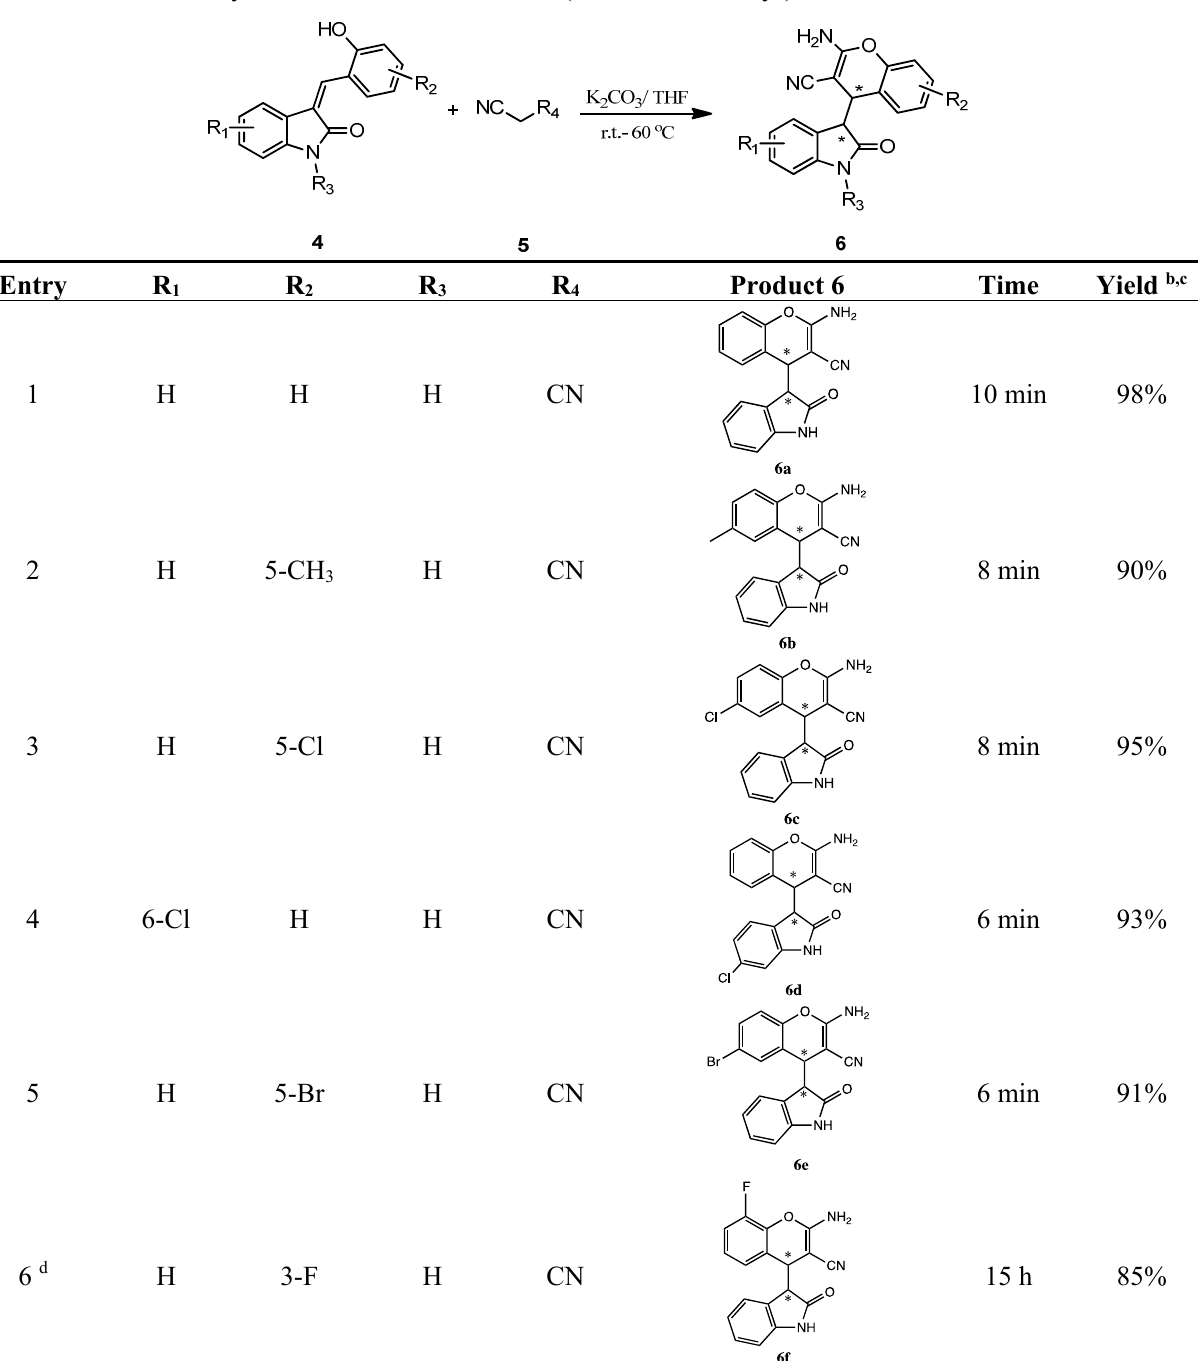
Table 2. Synthesis of new 2-amino-4-(2-oxoindolin-3-yl)-4 H -chromene 6a – m a